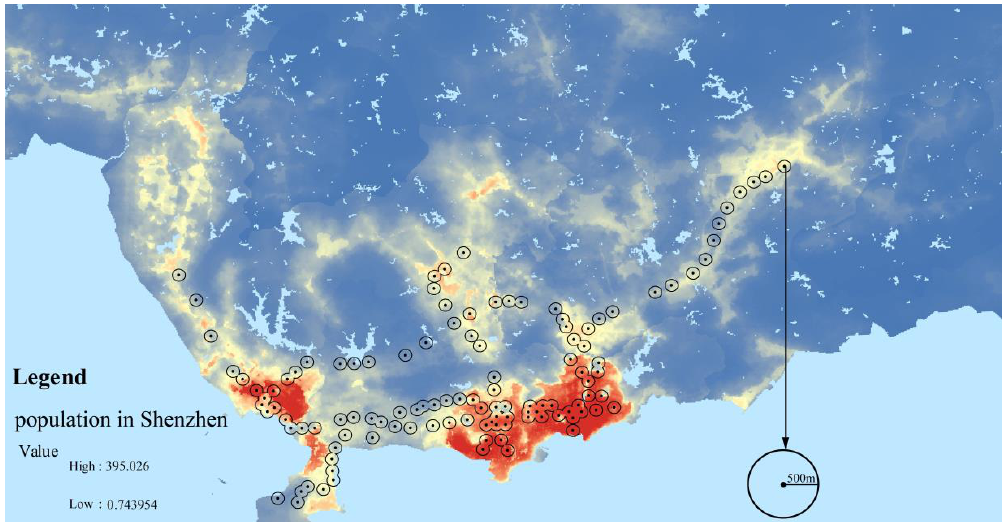
Figure 1. The 500 m buffers of metro stations and population distribution.